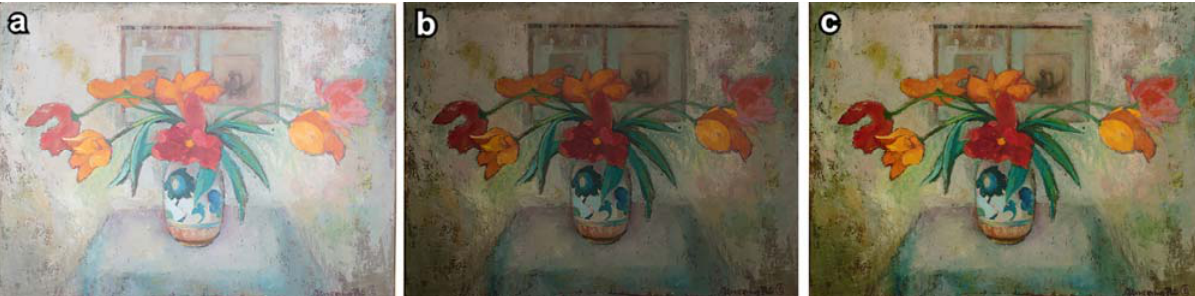
Figure 3. Image comparison according to color reproduction processing. (a) Camera profile image. (b) Color correction image. (c) Color reproduction